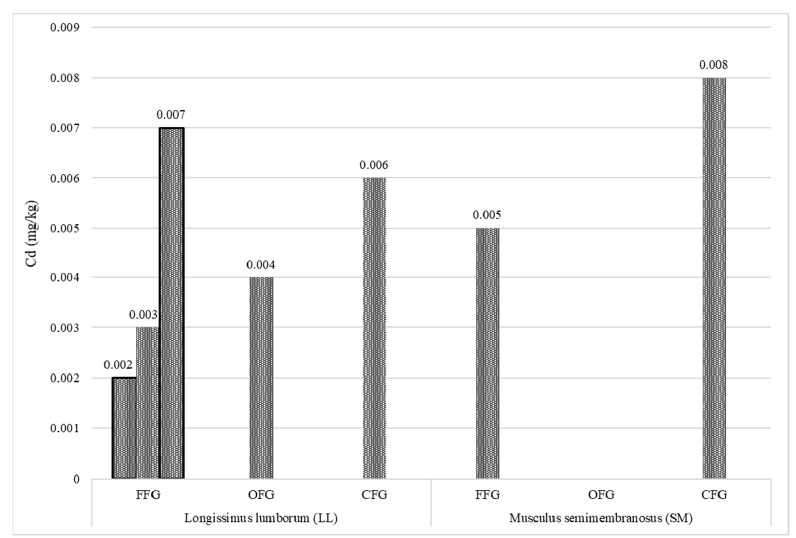
Figure 5. Number of Cd-containing meat samples (mg/kg) collected from the analyzed feeding grounds (FFG—forest feeding ground; OFG—organic feeding ground; CFG—conventional feeding ground).